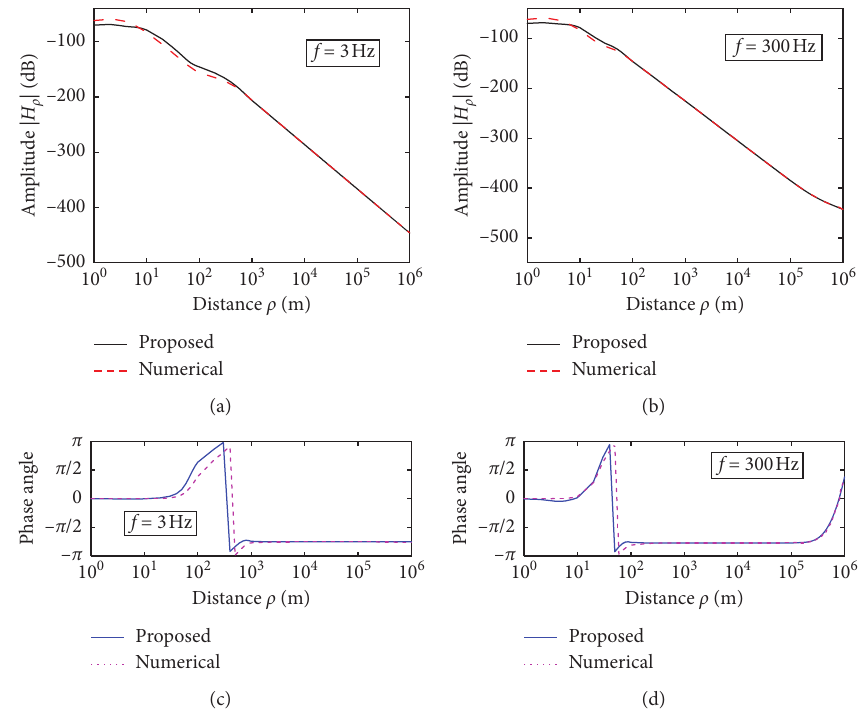
versus the propagation distance ρ with the proposed and numerical 2 ρ